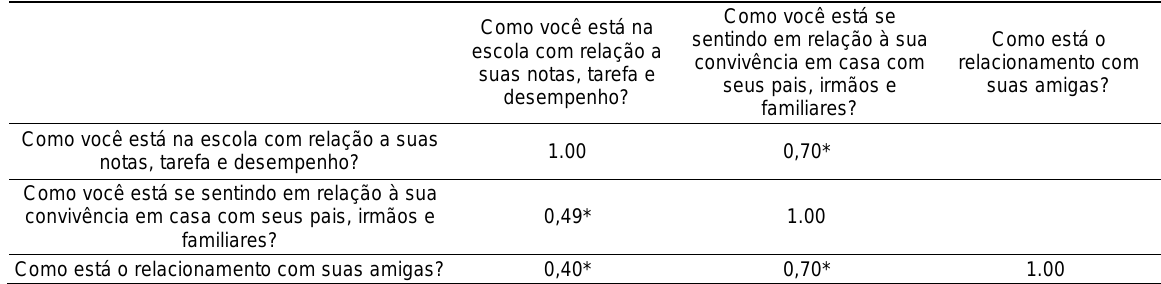
Tabela 1. Correlação entre as dinâmicas